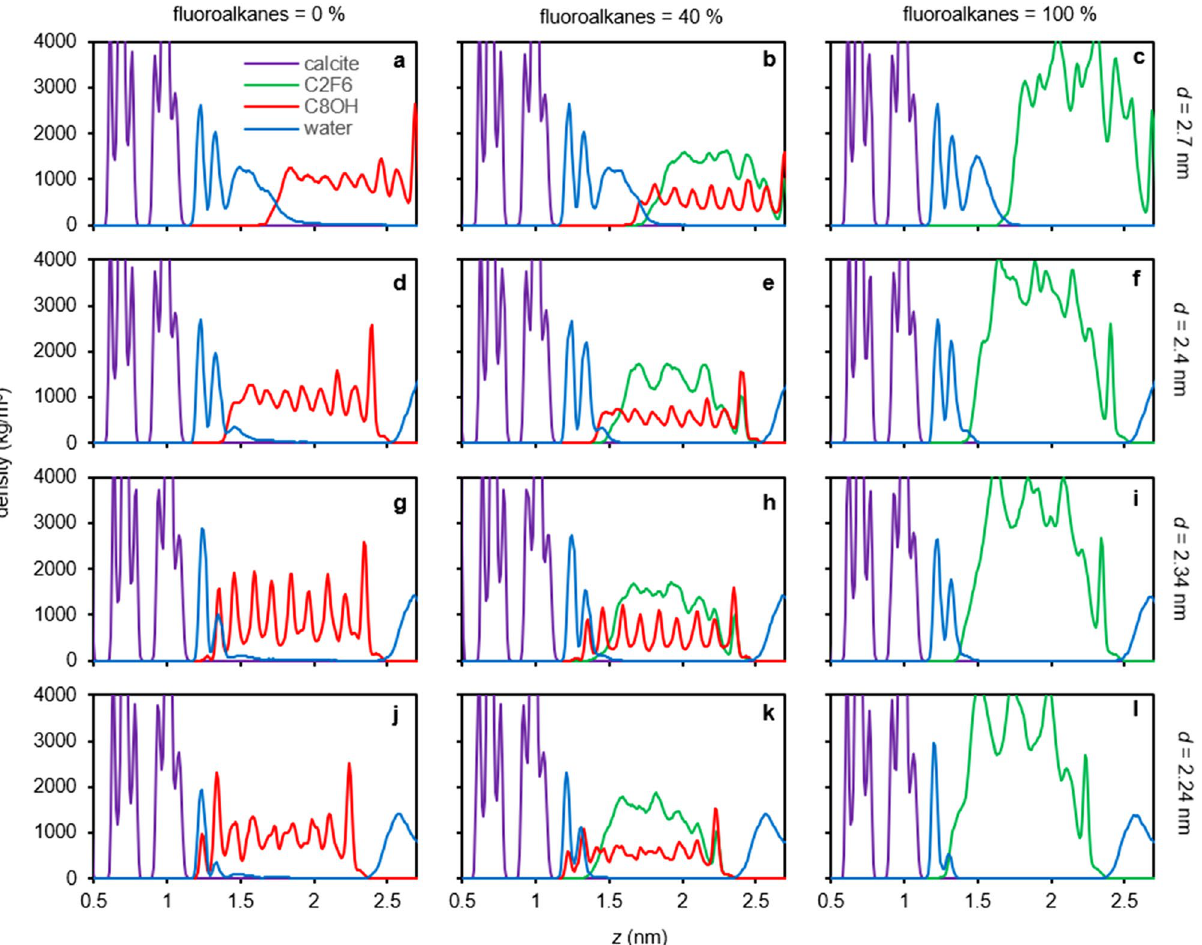
Figure 4. Density distributions for different C8OH-C2F6 SAM-calcite distances with different percentages of fluoroalkane. ( a–c ) d = 2.7 nm, ( d–f ) d = 2.4 nm, ( g–i ) d = 2.34 nm, and ( j–l ) d = 2.24 nm with 0% ( a , d , g , and j ), 40% ( b , e , h , and k ), and 100% ( c , f , i , and l ) fluoroalkanes. At d = 2.34 nm, the hydroxy groups on C8OH can participate in the second hydration layer ( g and h ). At d = 2.24 nm, the hydroxy groups on C8OH can